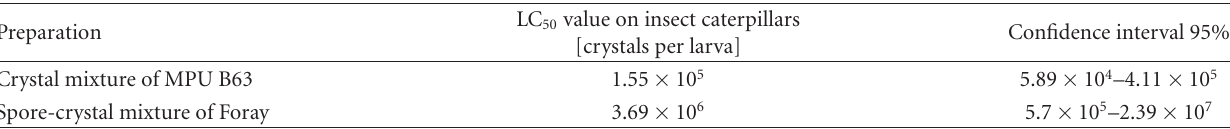
Table 2: The 50% lethal concentration (LC 50 ) of crystals of B. thuringiensis MPU B63 and Foray for C. pomonella caterpillars.